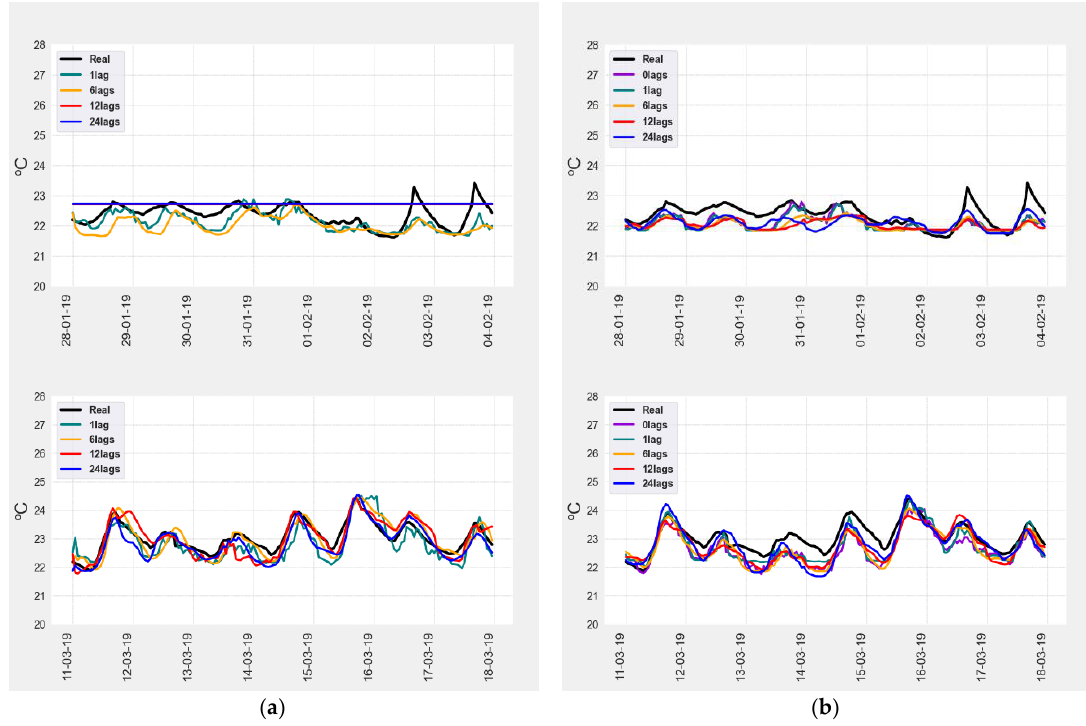
Figure 5. Results of the temperatures predictions in sample 1 (upper side) and sample 2 (bottom side) considering the different structures of time lags. Each architecture is represented by the prediction curve with the lowest error among the 10 repetitions: ( a ) LSTM models; ( b ) MLP models. LSTM models optimally predict the indoor temperatures of the building analyzed in this study.